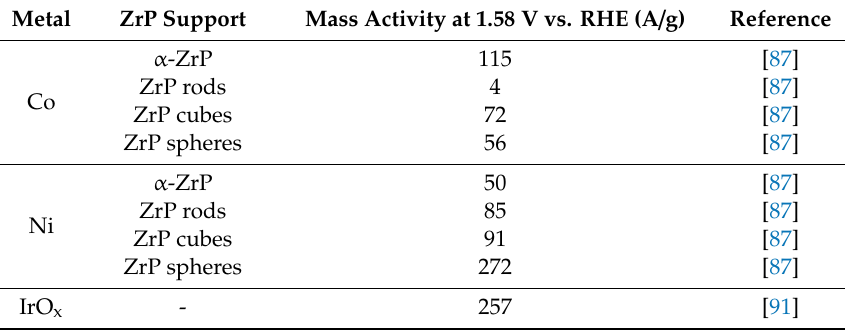
Table 2. Oxygen evolution reaction (OER) activity observed by mass activity analysis for the di ff erent metal-modified ZrP catalysts and benchmark catalyst IrO x in alkaline